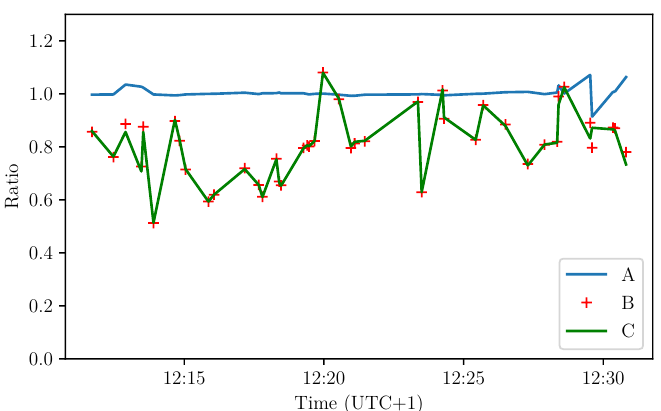
Figure 8. Ratio of the flux for the pyranometer and the corrected flux thanks to the reference and predicted attitude. ( A ) ratio between the reference flux and the predicted flux; ( B ) ratio between pyra- nometer flux and the predicted flux; ( C ) ratio between the pyranometer flux and the reference